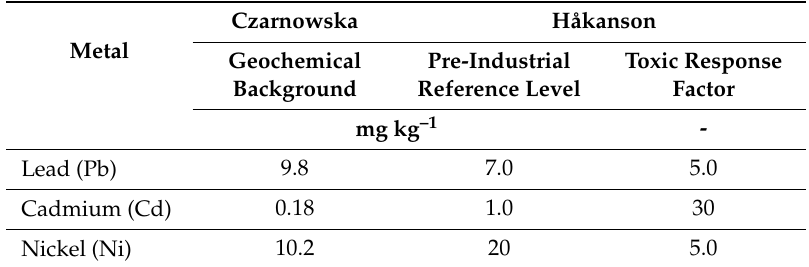
Table 1. Geochemical background, pre-industrial reference levels, and toxic response factors.